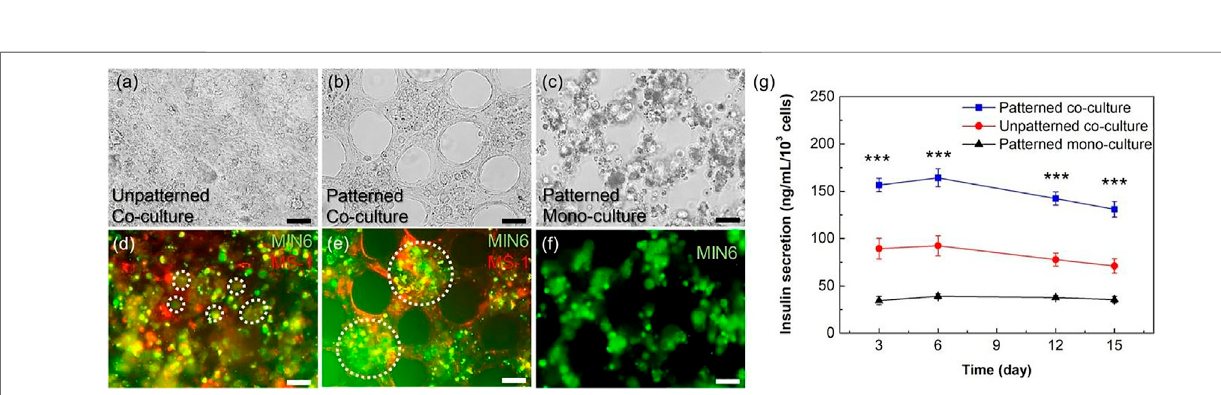
Frontiers in Bioengineering and Biotechnology |